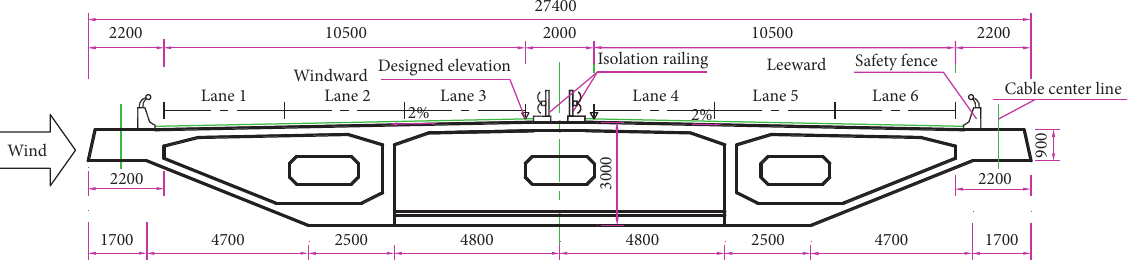
Figure 2: Configuration of the bridge deck at full scale (unit: mm).